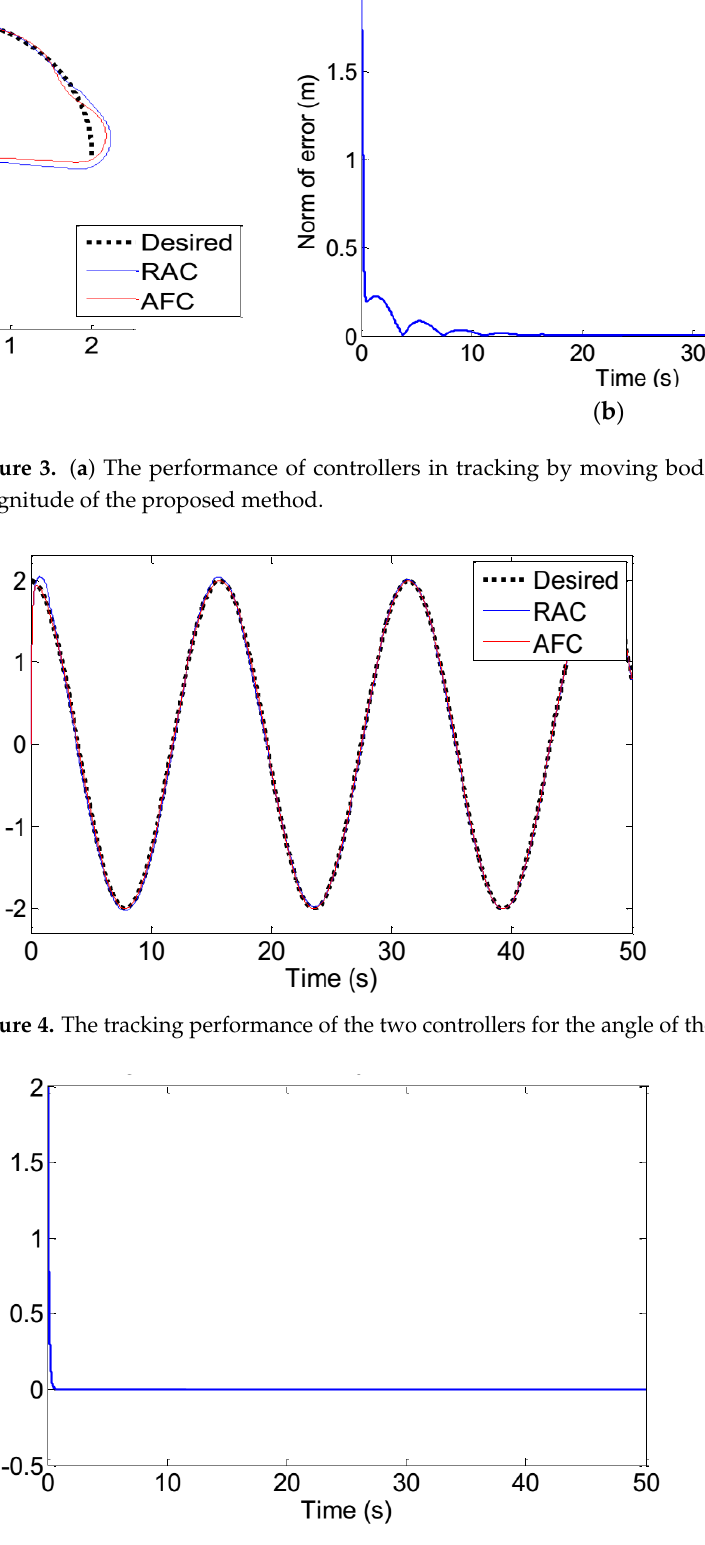
Figure 6. The magnitude of robot velocity error based on AFC and RAC. ( a ) ( b ) Figure 7. ( a ) Right wheel control signal and ( b ) Left wheel control signal.